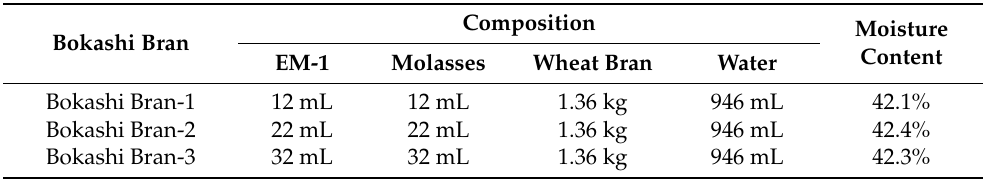
Table 2. The composition and moisture content of the bokashi